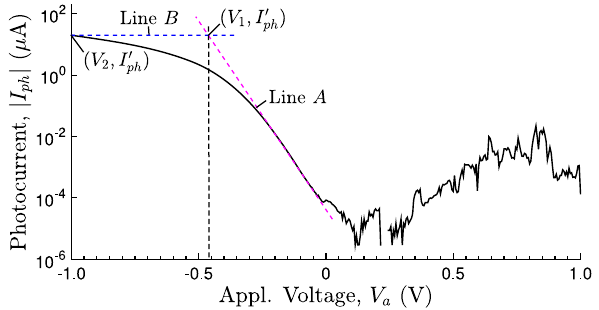
Figure 11: Procedure for estimating the series resistance R s from the measured log( | I | )– V curve under light